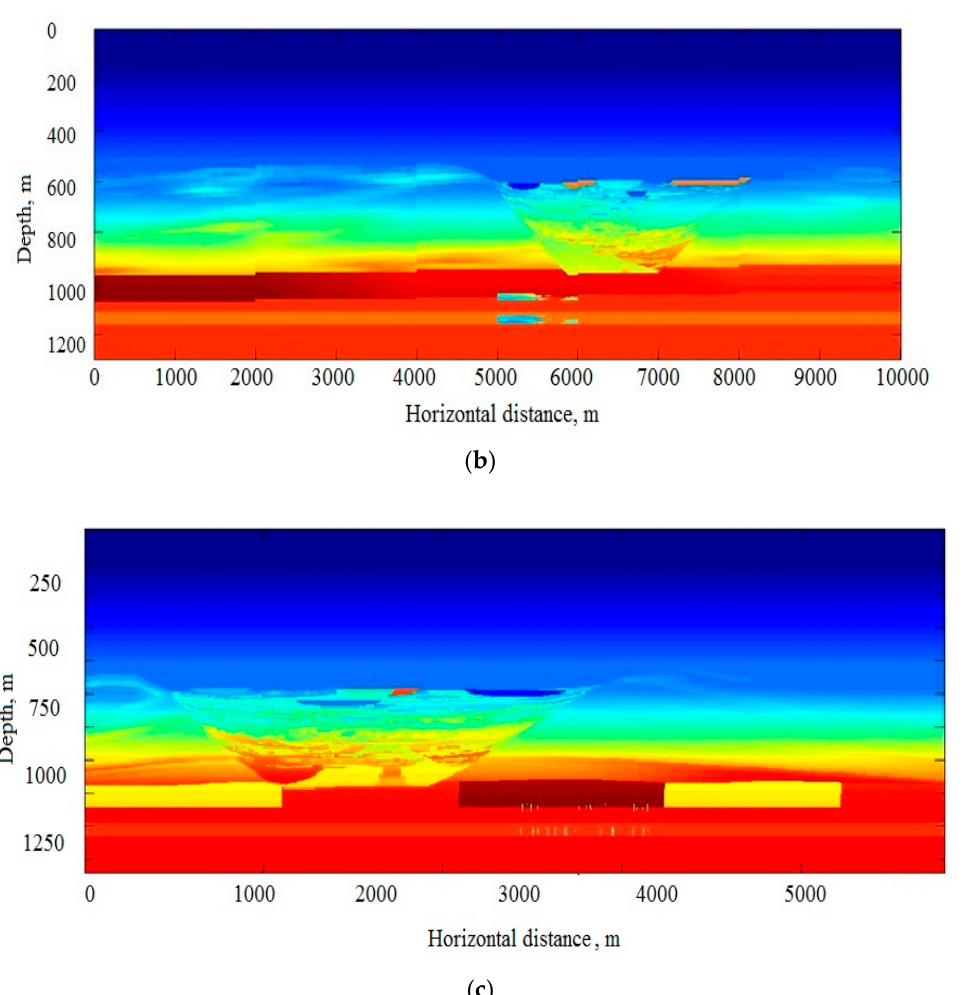
Figure 4. 3D heterogeneous multiscale geological model: paleo channel overrides fractured reservoir. ( a ) Horizontal cross-section at the depth 800 m, ( b , c ) two orthogonal vertical cross-sections through the middle of the model.